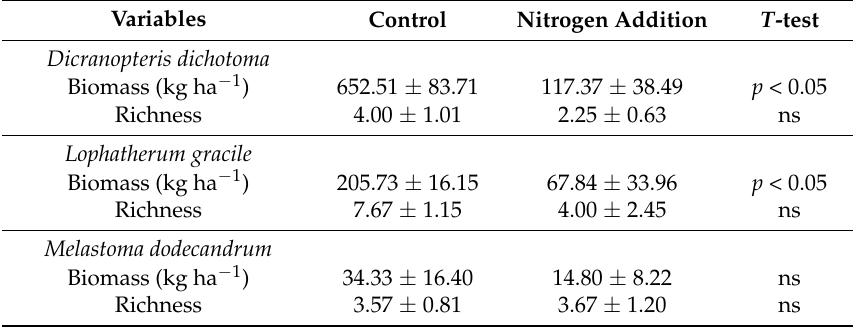
Table 1. The aboveground biomass and richness of the major understory plants in the Chinese fir forest plantation treated by nitrogen addition or in the control in 2015.